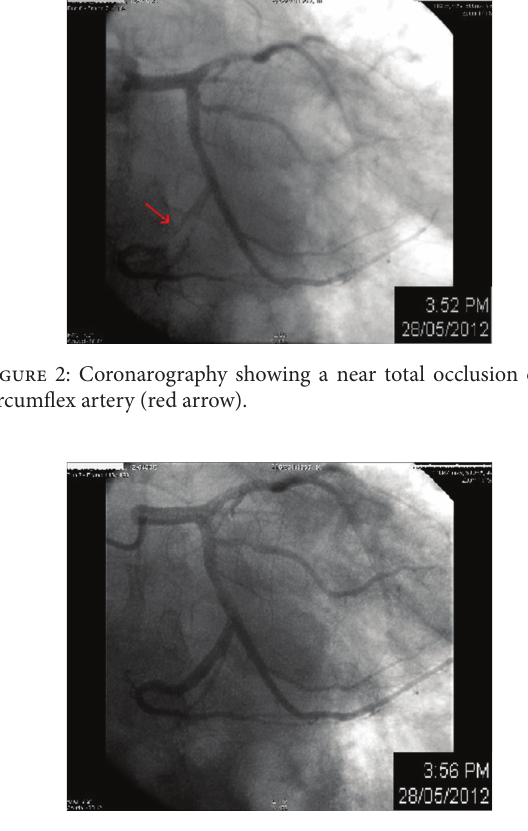
Figure 3: Relief of the stenosis after intracoronary